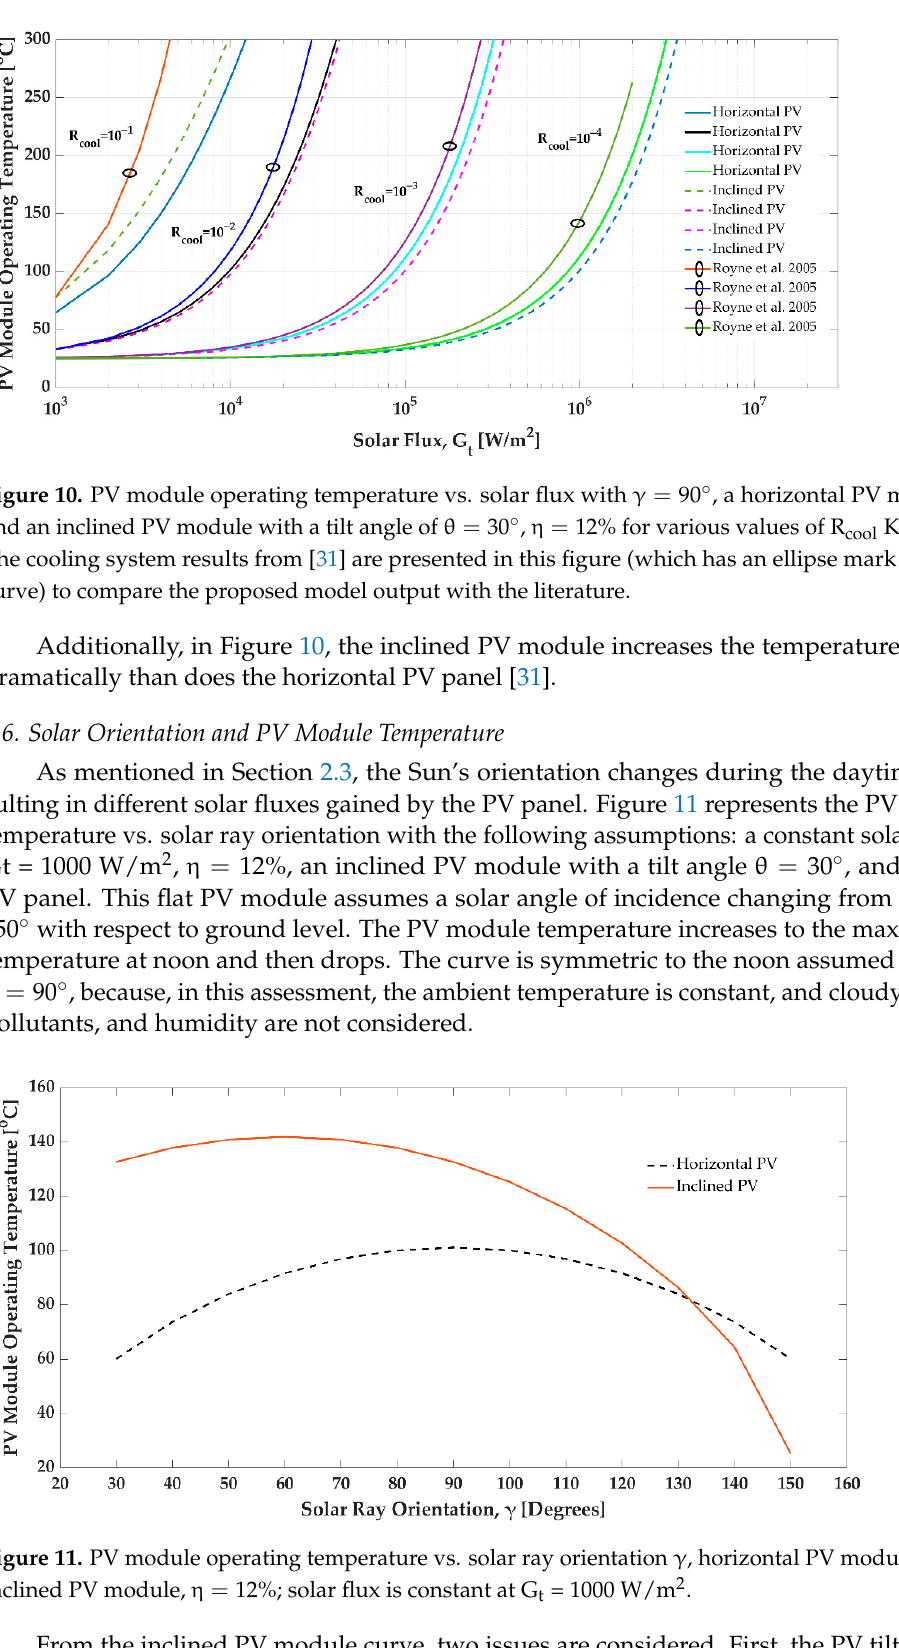
12 Figure 9. PV module operating temperature vs. solar flux with γ = 90° , horizontal PV module and an inclined PV module at η = 12% , without a cooling system. 3.5. PV Module Temperature and Cooling Systems The spate of studies consider a cooling system to control the PV panel operating tem-